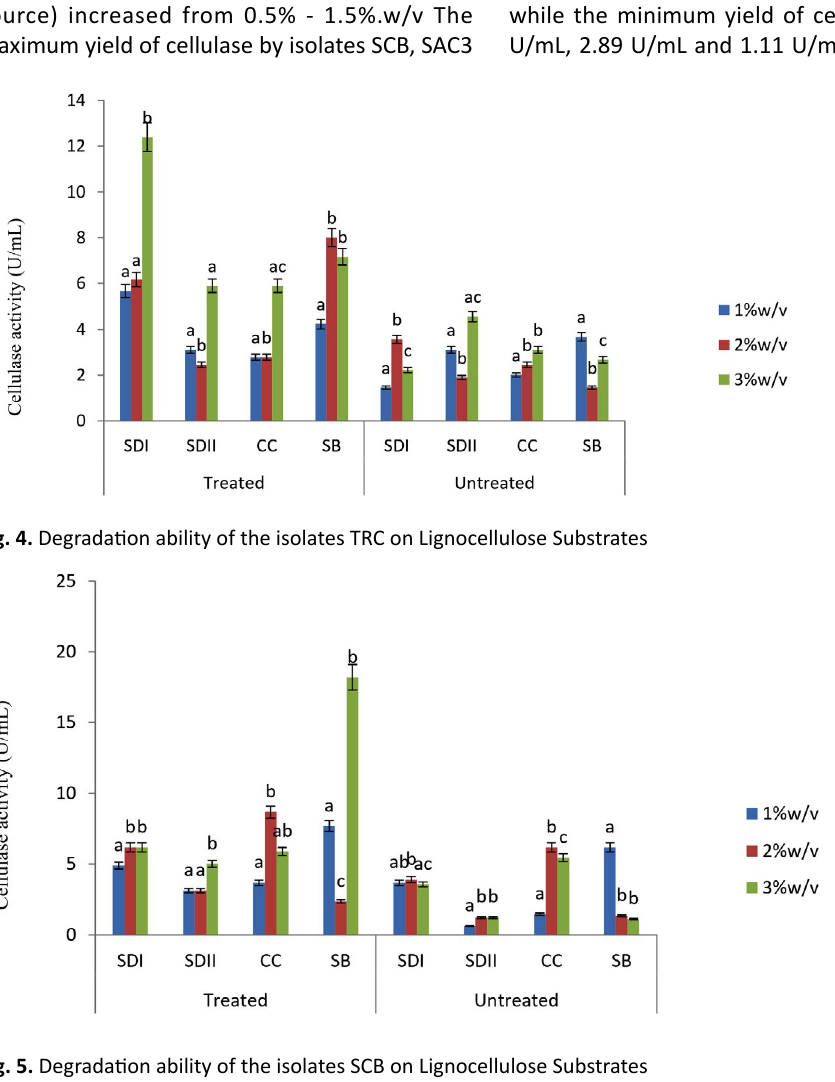
Fig. 5. Degradation ability of the isolates SCB on Lignocellulose SDI Araba wood ( Ceibapen tandra )—Sawdust, SDII Iroko wood ( Milicia excels ) —Sawdust: CC---Corn cob: SB— Sugar cane bagasse; Each value is a mean of two replicates; ± stands for standard deviation among replicates; Means with different letters within each substrate differ significantly (p ≤ 0.05) using Duncan`s Multiple Range